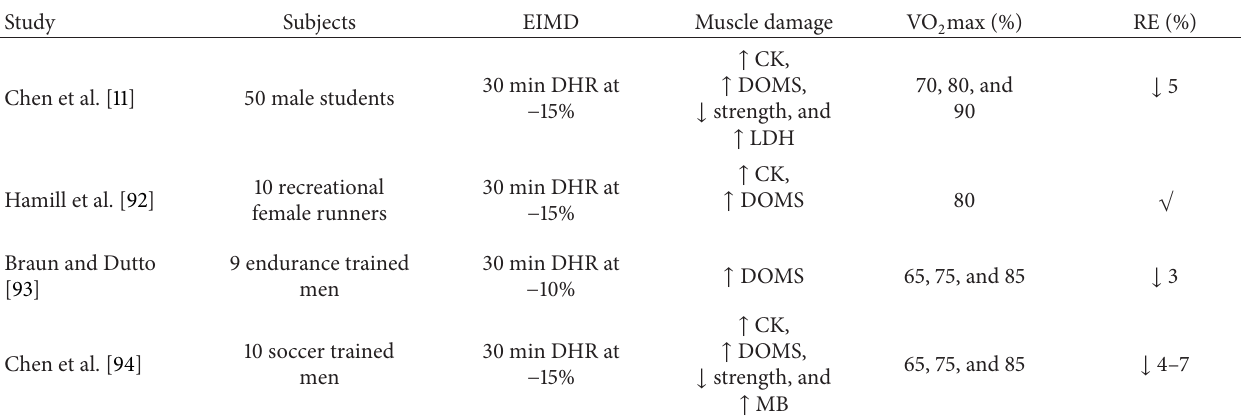
Table 2: Comparison of the effects of the downhill running on running